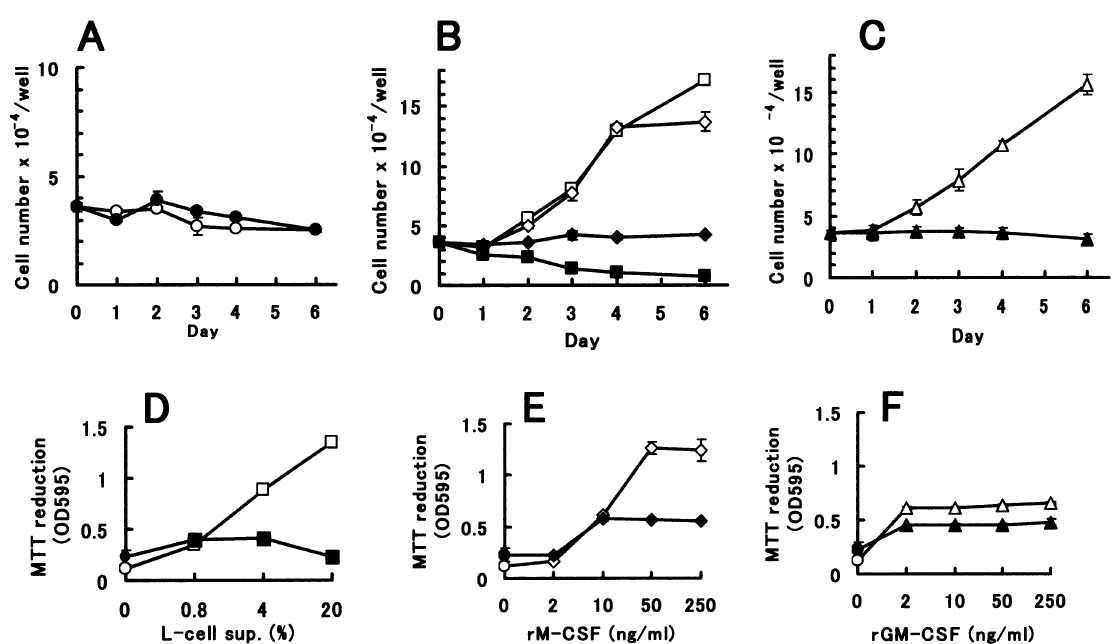
FIG. 3. Growth curves and MTT-reducing activities of the BAC1.2F5 cells cultured with securioside B in the presence of L-cell- conditioned medium, M-CSF or GM-CSF. (A) The BAC1.2F5 cells were cultured without ( k ) or with ( m ) 10 m g/ml securioside B in the absence of any macrophage growth-stimulating factor. The growth curves were estimated by cell counting. (B) and (C) Growth curves of the BAC1.2F5 cells cultured without (open symbols) or with (closed symbols) 10 m g/ml securioside B in the presence of 20% L-cell-conditioned medium ( I , j ), 100 ng/ml rM-CSF ( 2 , " ), or rGM-CSF ( ^ , ' ). Bars represent upper and lower values of duplicate estimations. (D (cid:1) / F) MTT-reducing activities of the cells treated without (open symbols) or with (closed symbols) 10 m g/ml securioside B in the presence of the indicated concentrations of L-cell-conditioned medium (D), rM- CSF (E), or rGM-CSF (F). MTT-reducing activity was measured on day